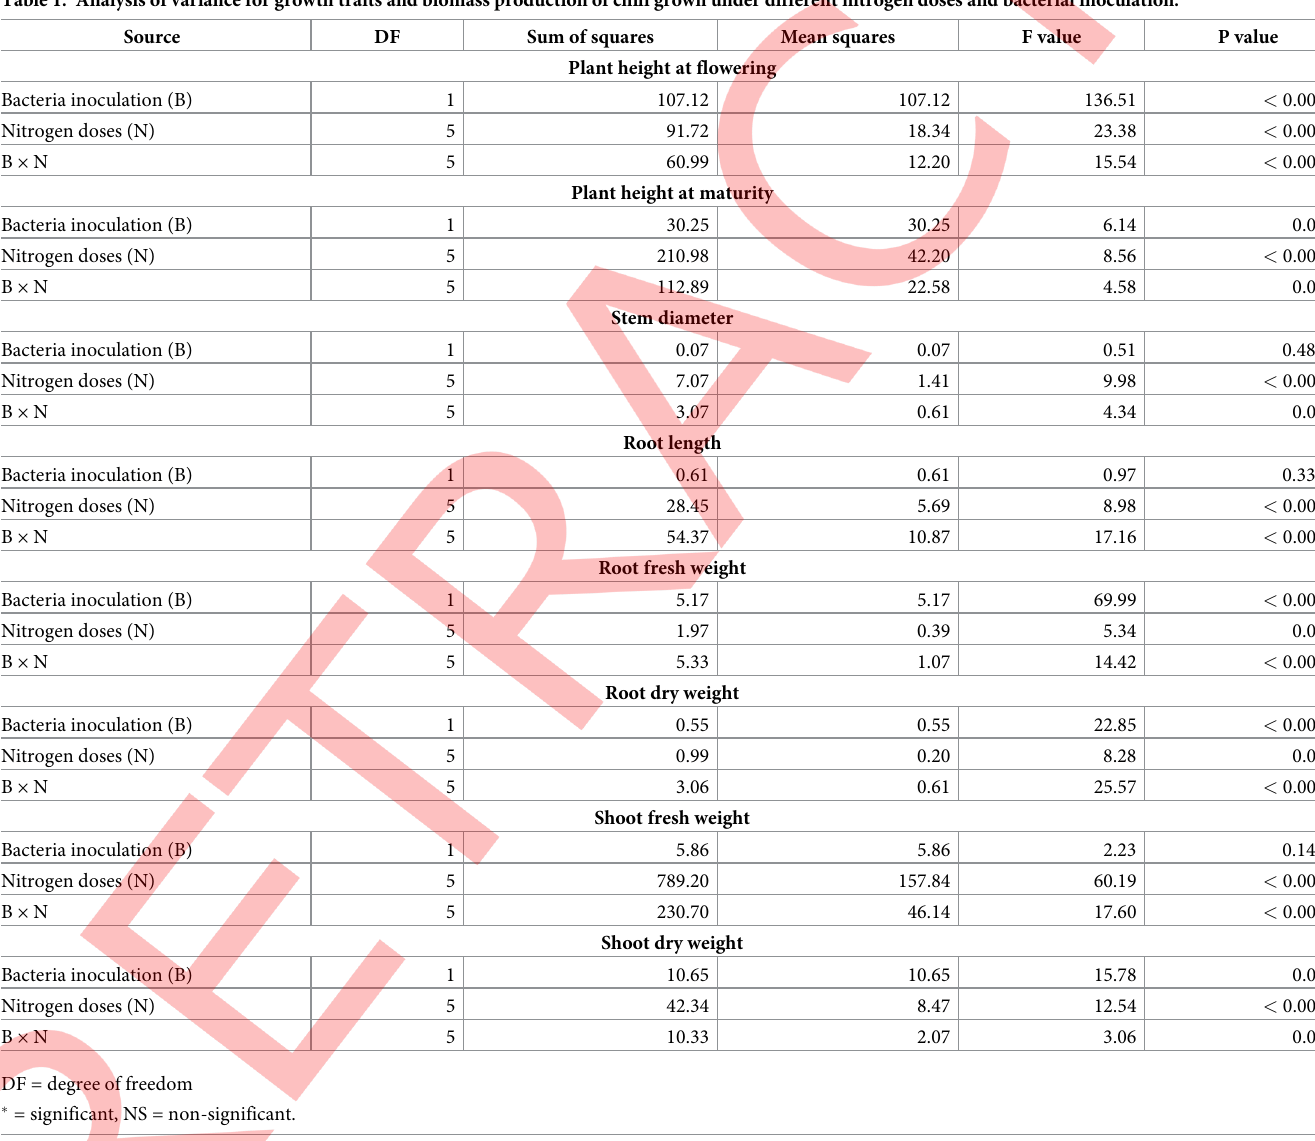
Table 1. Analysis of variance for growth traits and biomass production of chili grown under different nitrogen doses and bacterial inoculation. Source DF Sum of squares Mean squares F value P value Plant height at flowering 1 107.12 107.12 136.51 < 0.0001 �